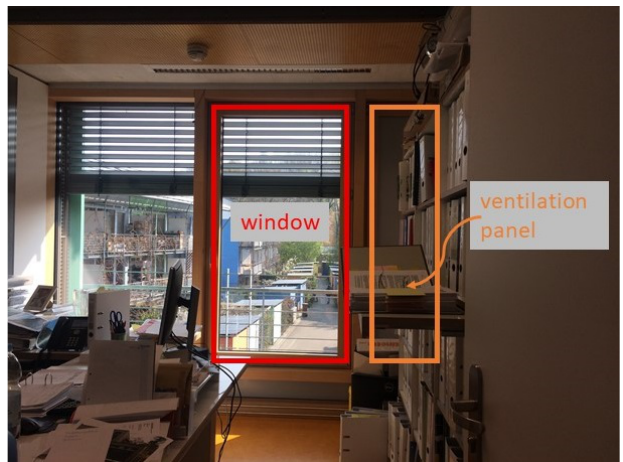
Figure 7. View into the investigated office room with highlighted window and ventilation panel [Fraunhofer ISE].